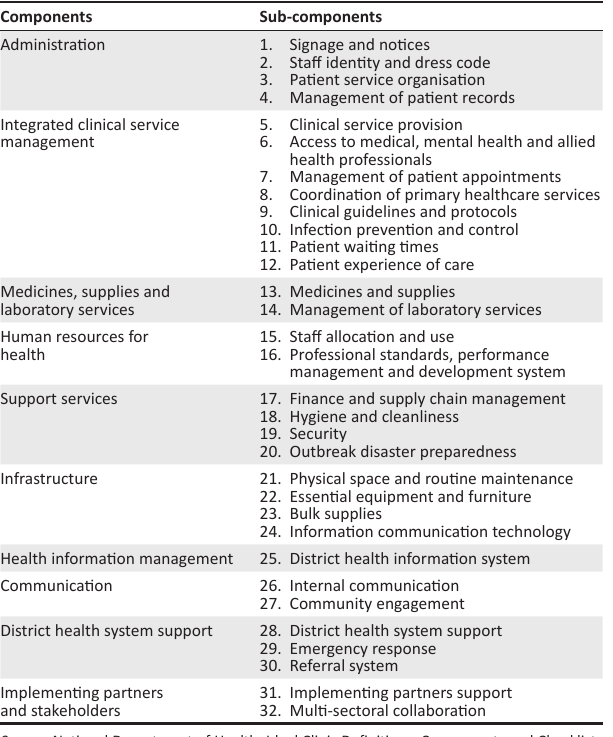
TABLE 1: Framework of the ideal clinic